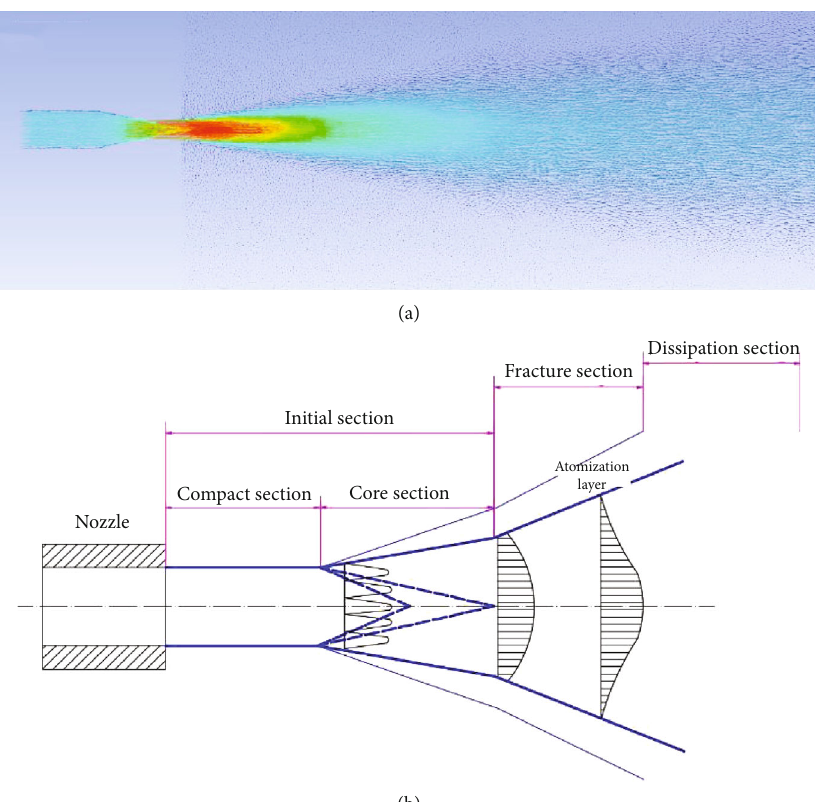
Figure 3: Shape of the water